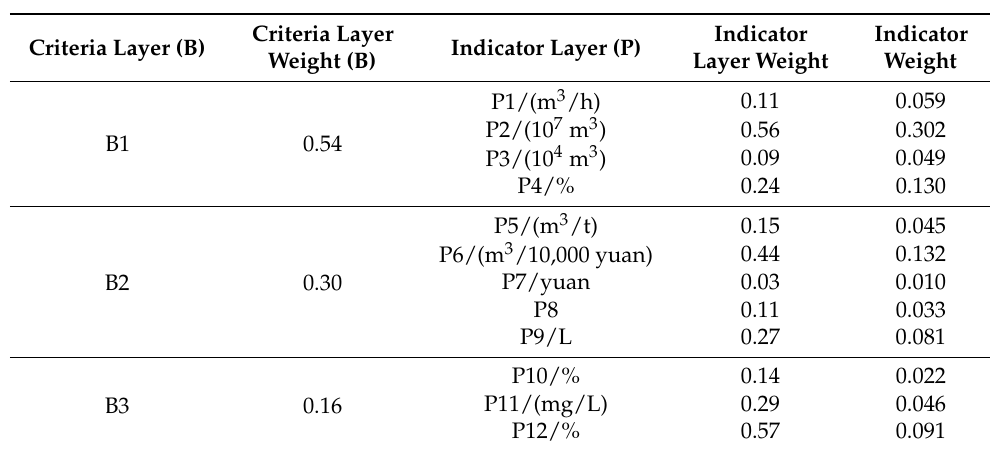
Table 10. Indicator weight